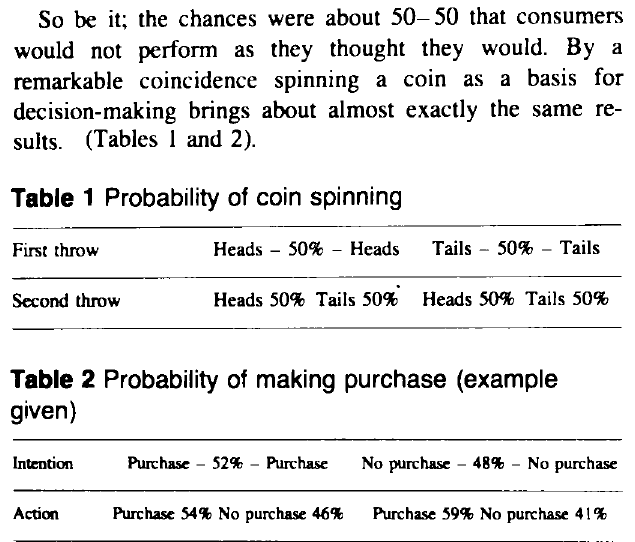
Table 2 Probability of making purchase